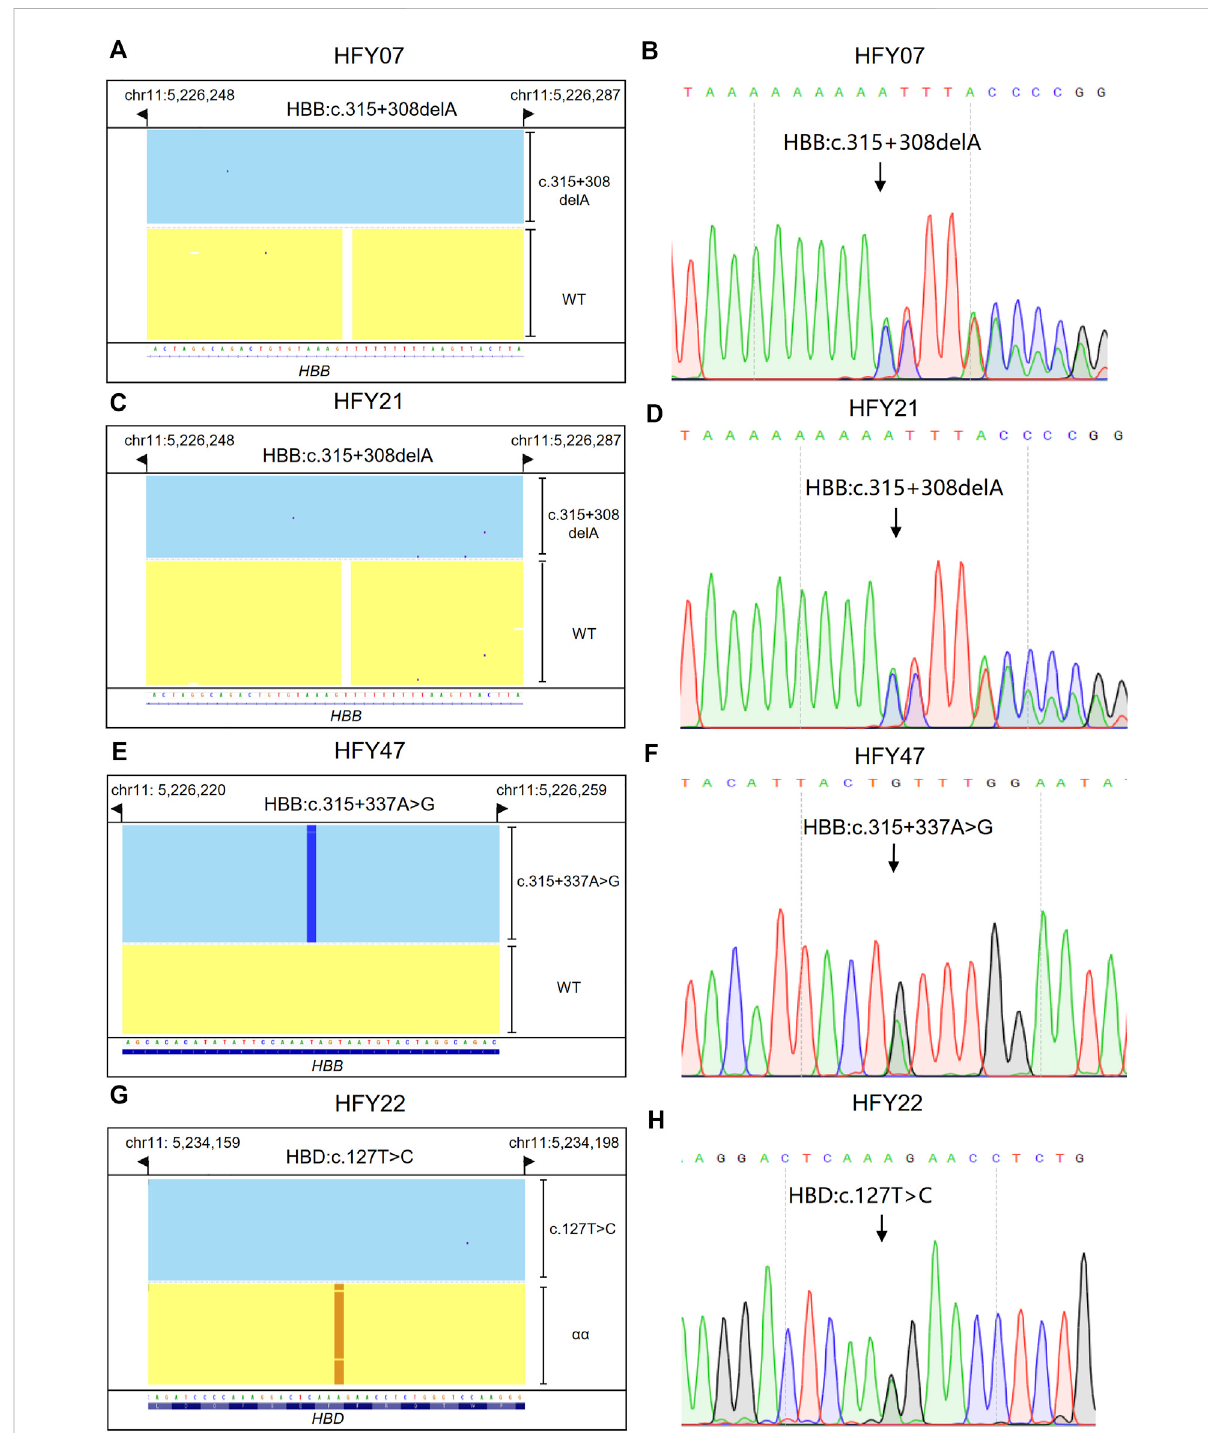
FIGURE 4 Integrative Genomics Viewer plots and Sanger sequencing of the SNVs and indels identi fi ed by CATSA. (A,C,E,G) IGV plots of HBB: c.315+308delA heterozygote, HBB:c.315+337 A > G heterozygote, and HBD:c.127T > C heterozygote. Blue and yellow areas indicate two chromosomes. (B,D,F,H) The SNVs and indels of HBB:c.315+308delA heterozygote, HBB:c.315+337 A > G heterozygote, and HBD:c.127 T > C heterozygote identi fi ed by Sanger